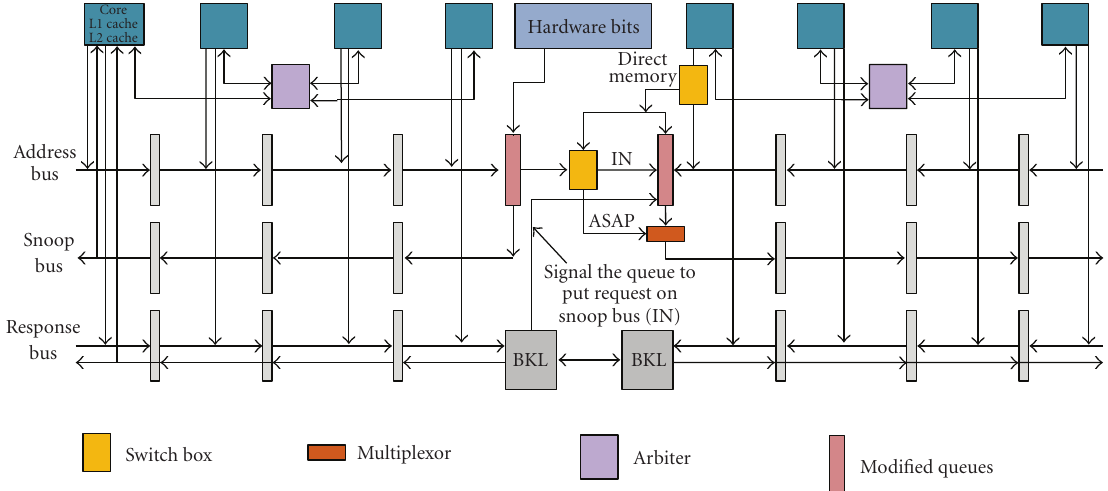
Figure 11: Intercluster logic between two